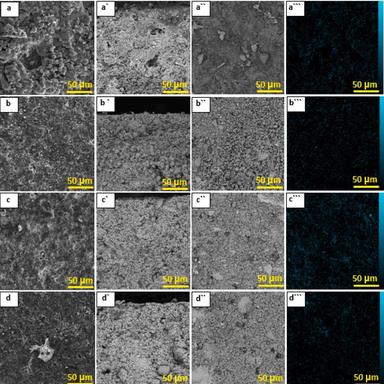
FESEM and EDS mapping of the ceramic membranes incorporated by PS after oily wastewater treatment. a) Outer surface of M-Z, a') Cross-section of M-Z, a'`) Inner surface of M-Z, a'``) Carbon element on the inner surface of M-Z, b) Outer surface of M-Z-PS10, b') Cross-section of M-Z-PS10, b'`) Inner surface of M-Z-PS10, b'``) Carbon element on the inner surface of M-Z-PS10, c) Outer surface of M-Z-PS20, c') Cross-section of M-Z-PS20, c'`) Inner surface of M-Z-PS20, c'``) Carbon element on the inner surface o